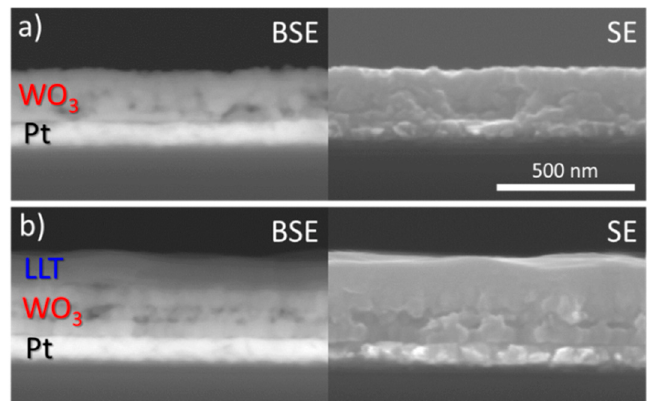
Figure 2. Cross-section SEM micrograph showing backscattered (BSE) and secondary electron (SE) images: ( a ) 10 cycles of W-precursor deposition on a planar Pt substrate, annealed at 600 °C; and ( b ) 20 cycles of Li-La-Ti-precursor deposition on WO 3 /Pt substrate, annealed at 500 °C.